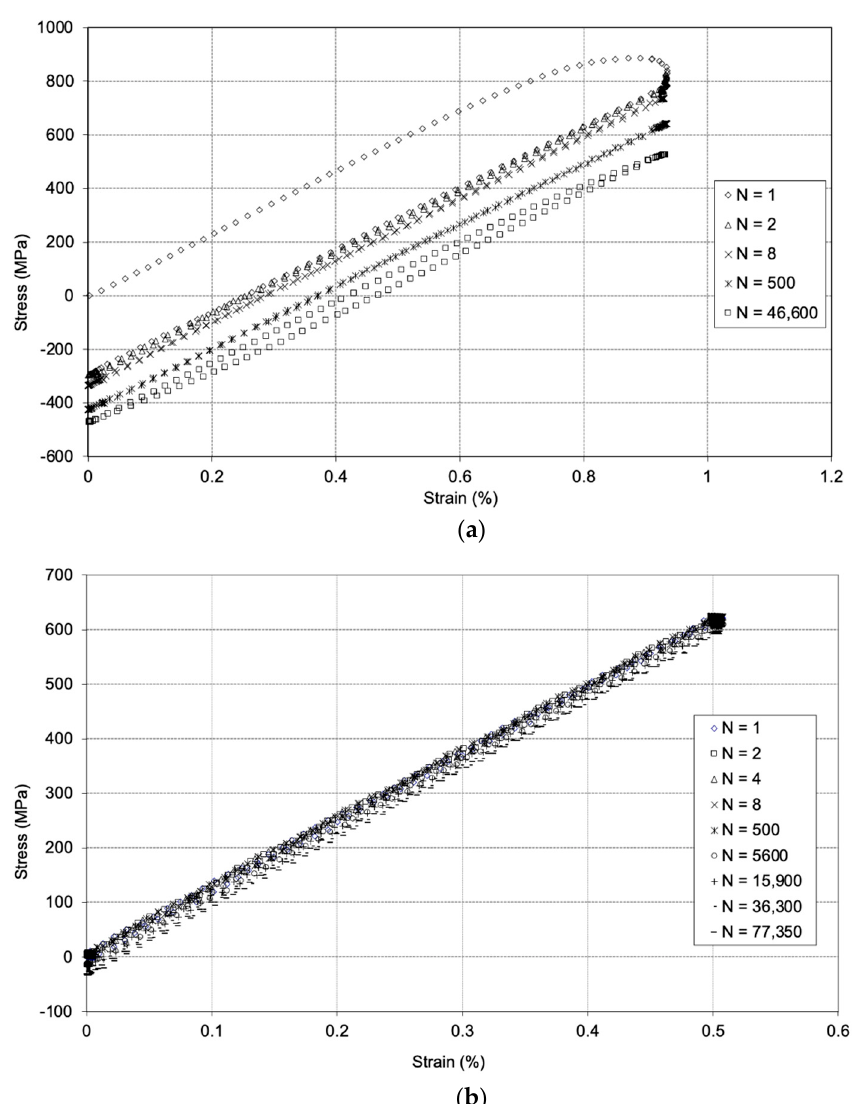
Figure 17. Selected hysteresis loops for strain-controlled fatigue tests performed towards the extremes of peak strain conditions: ( a ) 0.93% and ( b ) 0.5%.